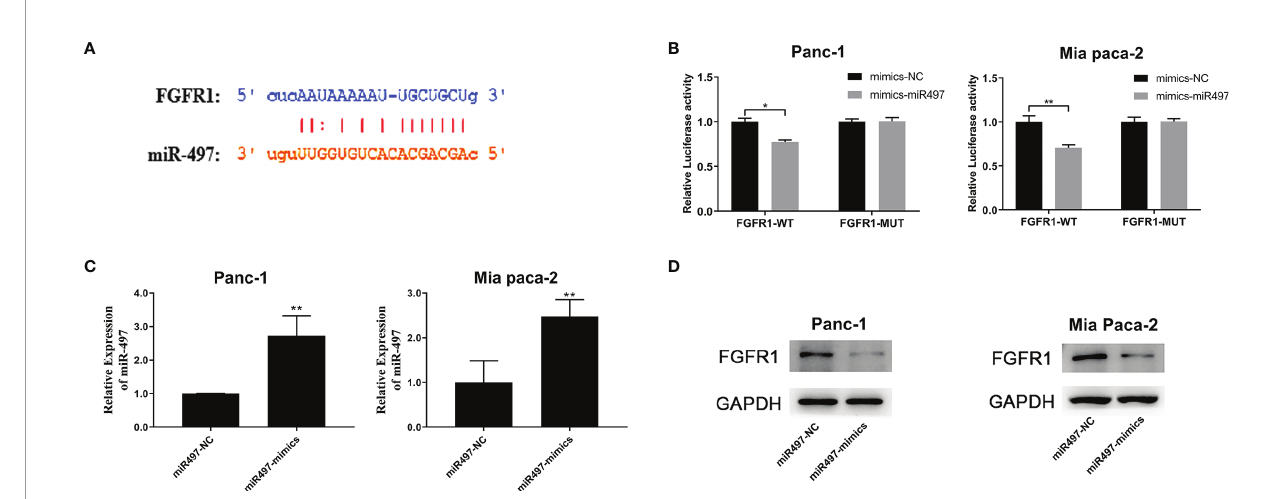
FIGURE 7 | FGFR1 is targeted by miR-497 and is regulated by SNHG1 in PC cells. (A) TargetScan prediction of the miR-497 binding site on FGFR1. (B) Luciferase activity of FGFR1 wild-type was reduced after transfection with miR-497 mimics. (C) qRT-PCR quanti fi cation of miR-497 expression after transfection of miR-497 mimics/NC. (D) Reduced FGFR1 protein expression after transfection with miR-497 mimics. *p < 0.05, **p < 0.01.